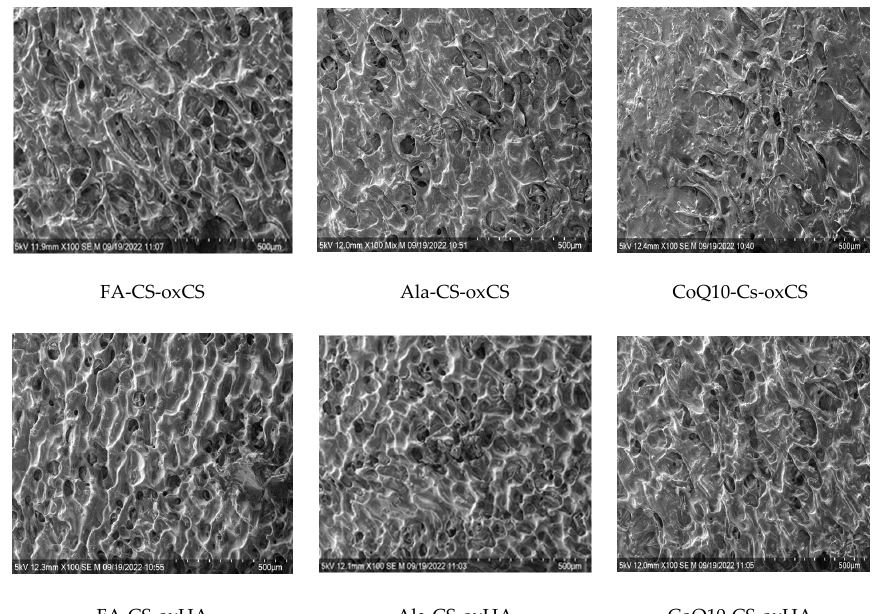
Figure 5. The SEM images of API-CS–oxCS/oxHA hydrogels.